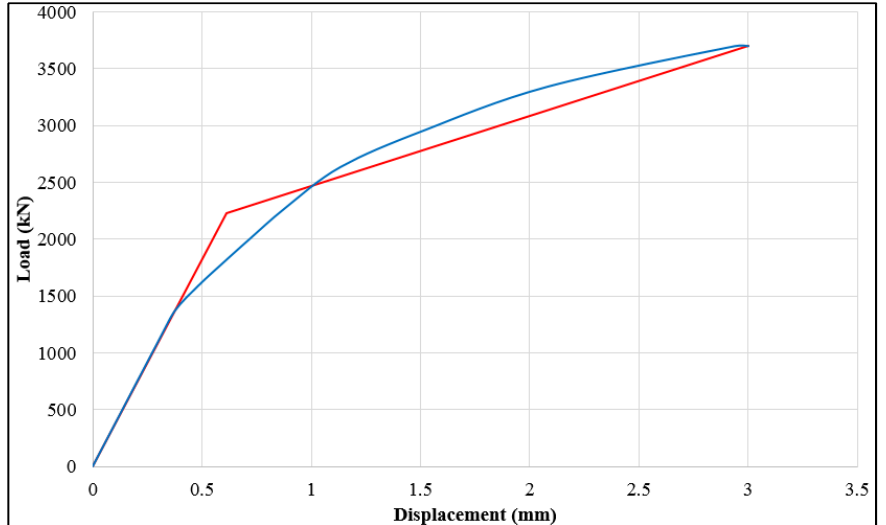
Figure 6. Load-Capacity—Bilinear Graph for Group F.